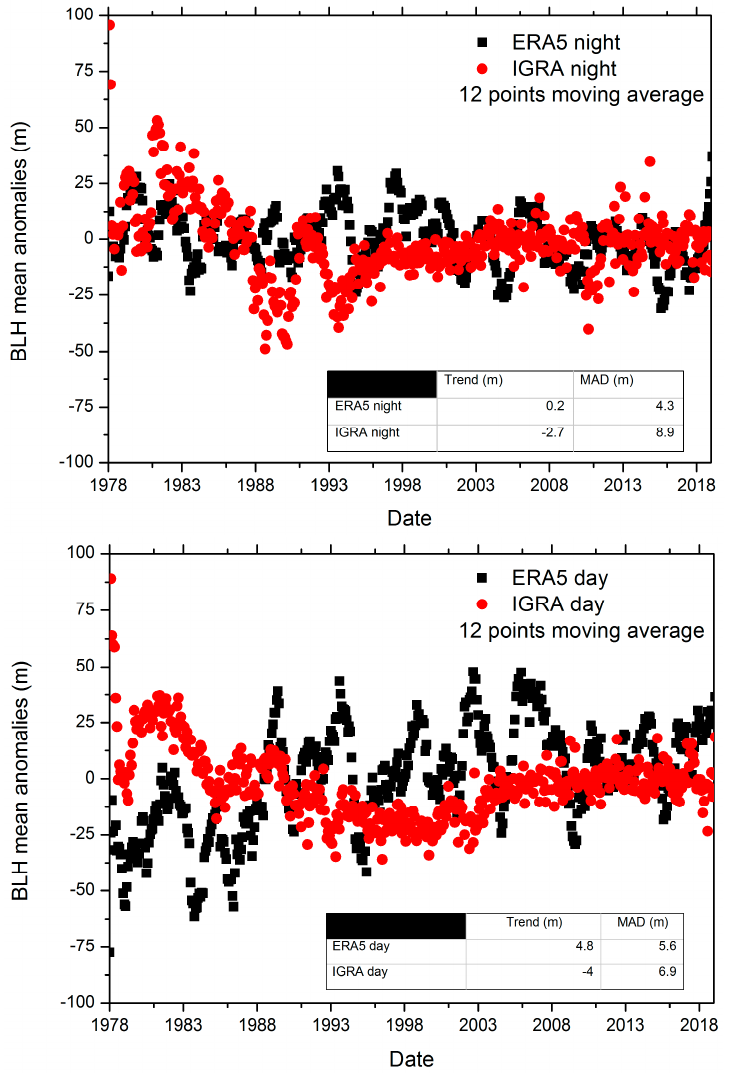
Figure 5. Top panel, comparison of the ERA5 (black dots) and IGRA (red dots) nighttime BLH mean monthly anomalies for the stations reported in Figure 4; bottom panel, same as top panel for daytime anomalies. Both panels embed a table with the estimation of the decadal trend and the median absolute deviation (MAD). All the shown anomalies are obtained applying a 12-point moving average on the original time series.